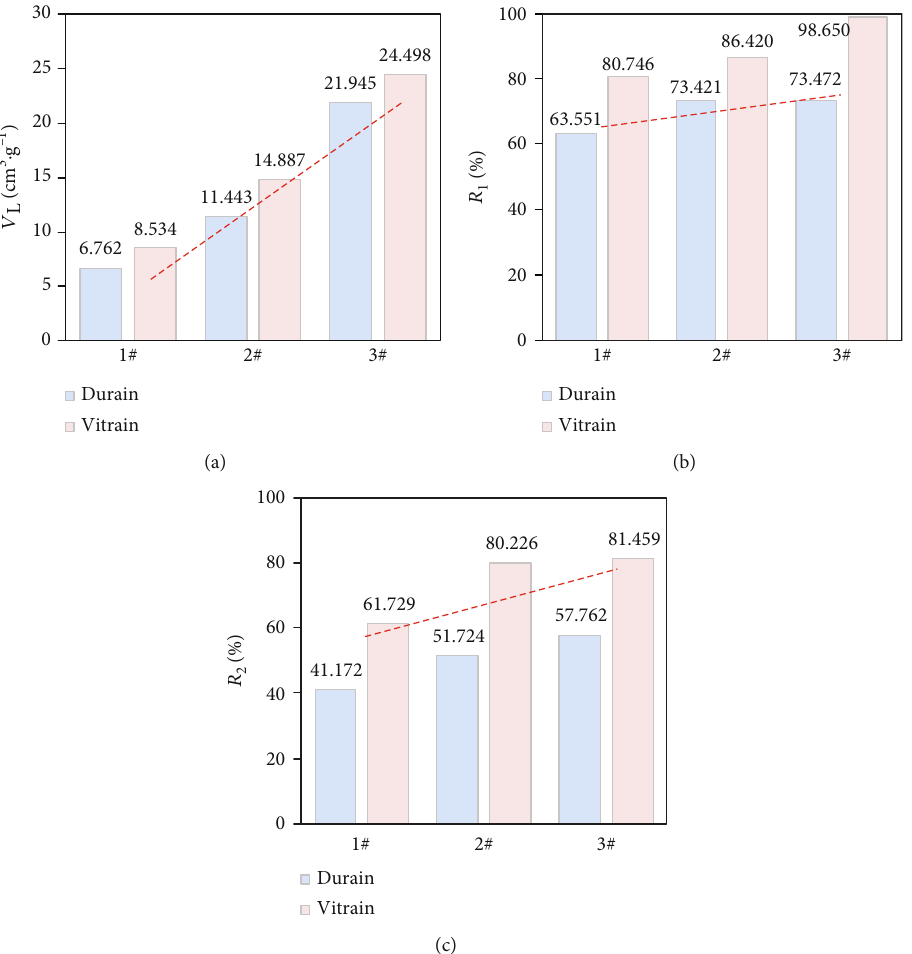
Figure 9: Adsorption and desorption parameters for vitrain and